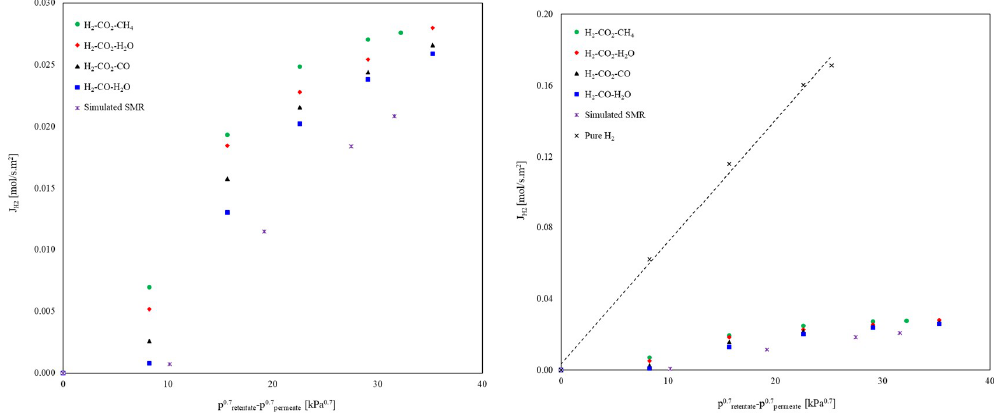
Figure 9. H 2 permeation flux in simulated SMR stream using Pd/YSZ membrane.